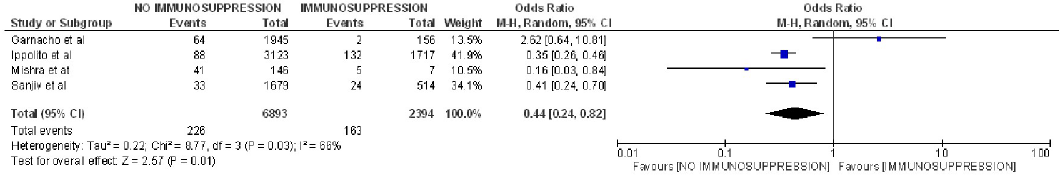
Fig 4. Forest Plot of immune system ompromiso and CLABSI.